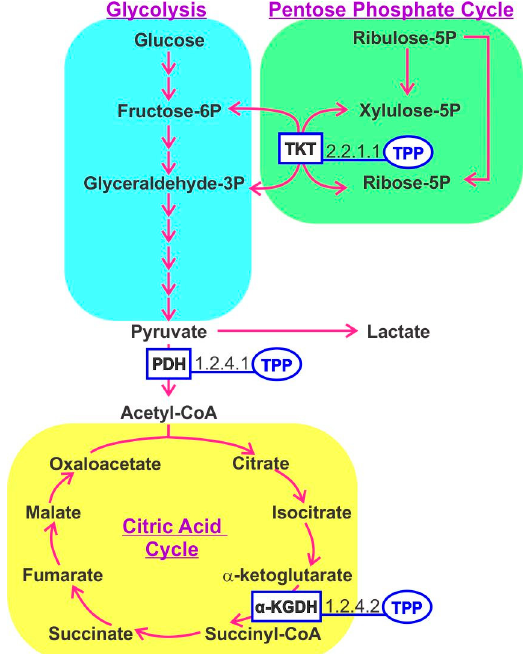
Figure 2. The central carbohydrate metabolism pathways involving thiamine pyrophosphate (TPP)-dependent enzymes. TPP serves as a cofactor for steps regulating the pentose phosphate cycle, fate of pyruvate and the tricarboxylic acid cycle. TKT; transketolase, PDH; pyruvate dehydrogenase, KGDH; α -ketoglutarate dehydrogenase.